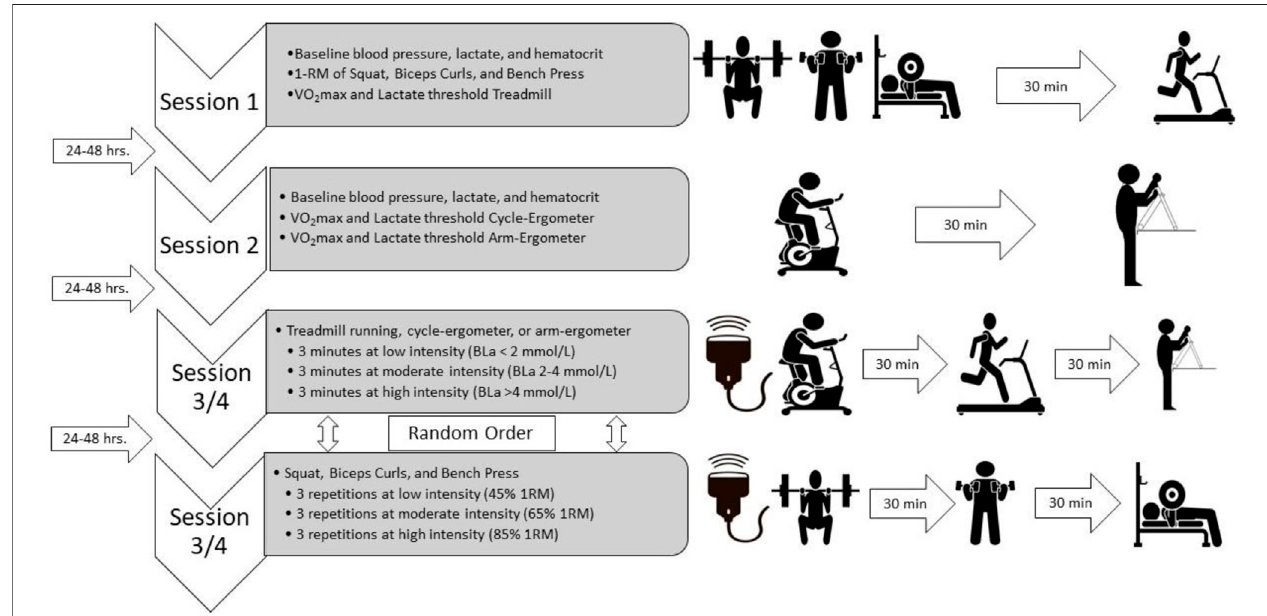
FIGURE1| Studydesign.Fourexercisesessions,2formaximaltests and2forsubmaximaltests,with24 – 48 hbetweensessions.Ultrasoundassessmentduring both submaximal sessions and exercise modalities sets were randomly assigned to either session 3 or session 4. VO2max, maximal oxygen consumption; BLa, blood lactate